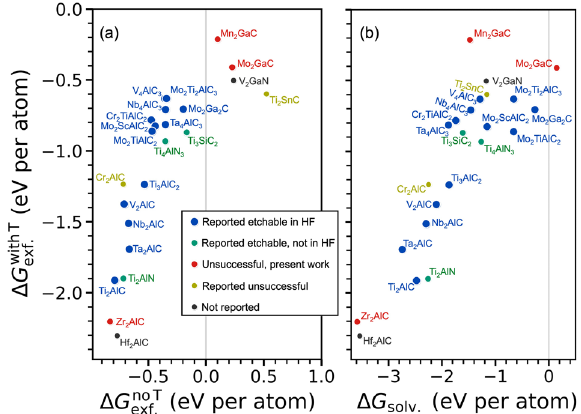
Fig. 1 Comparison of exfoliation and solvation free energies of MAX phases. Exfoliation free energies for the chemical exfoliation of MAX phases when including termination groups on the resulting ) compared to a the exfoliation free energy without MXene ( Δ G with T exf : ) and b the solvation free energies ( Δ G solv. ). terminations ( Δ G no T exf : Notice that the graphs in ( a ) and ( b ) share the same y -axis. Exfoliation and solvation free energies were calculated with Eqs. (2) and (3), respectively, for pH = 0 and an ion concentration of 10 − 3 mol dm − 3